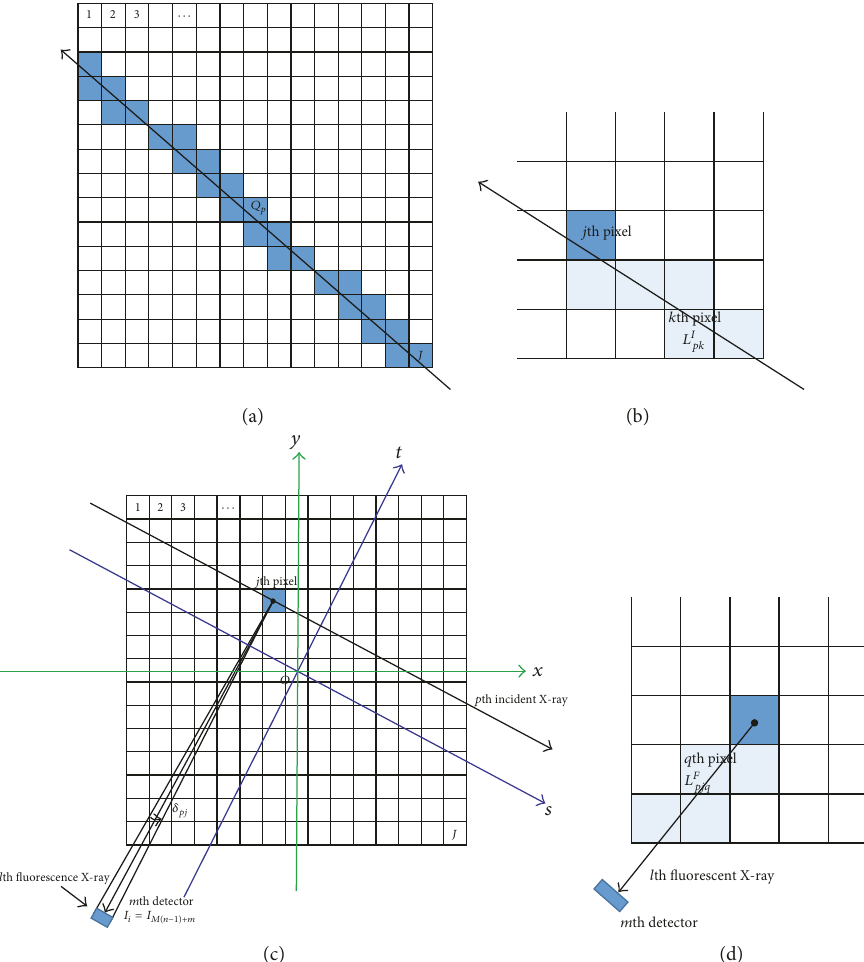
Figure 6: The parameters defined for discretized presentation. (a) A set 𝑄 𝑝 defined for blue squares intersected by the p th incident X-ray. (b) A set 𝑄 𝑝𝑗 defined for light blue squares intersected by the p th incident X-ray. (c) Definition of 𝛿 𝑖𝑗 , m . (d) A set T squares intersected by l th fluorescent